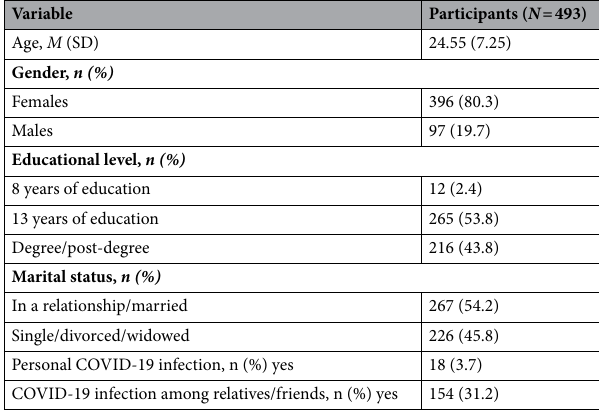
Table 1. Participants’ demographic information and health-related